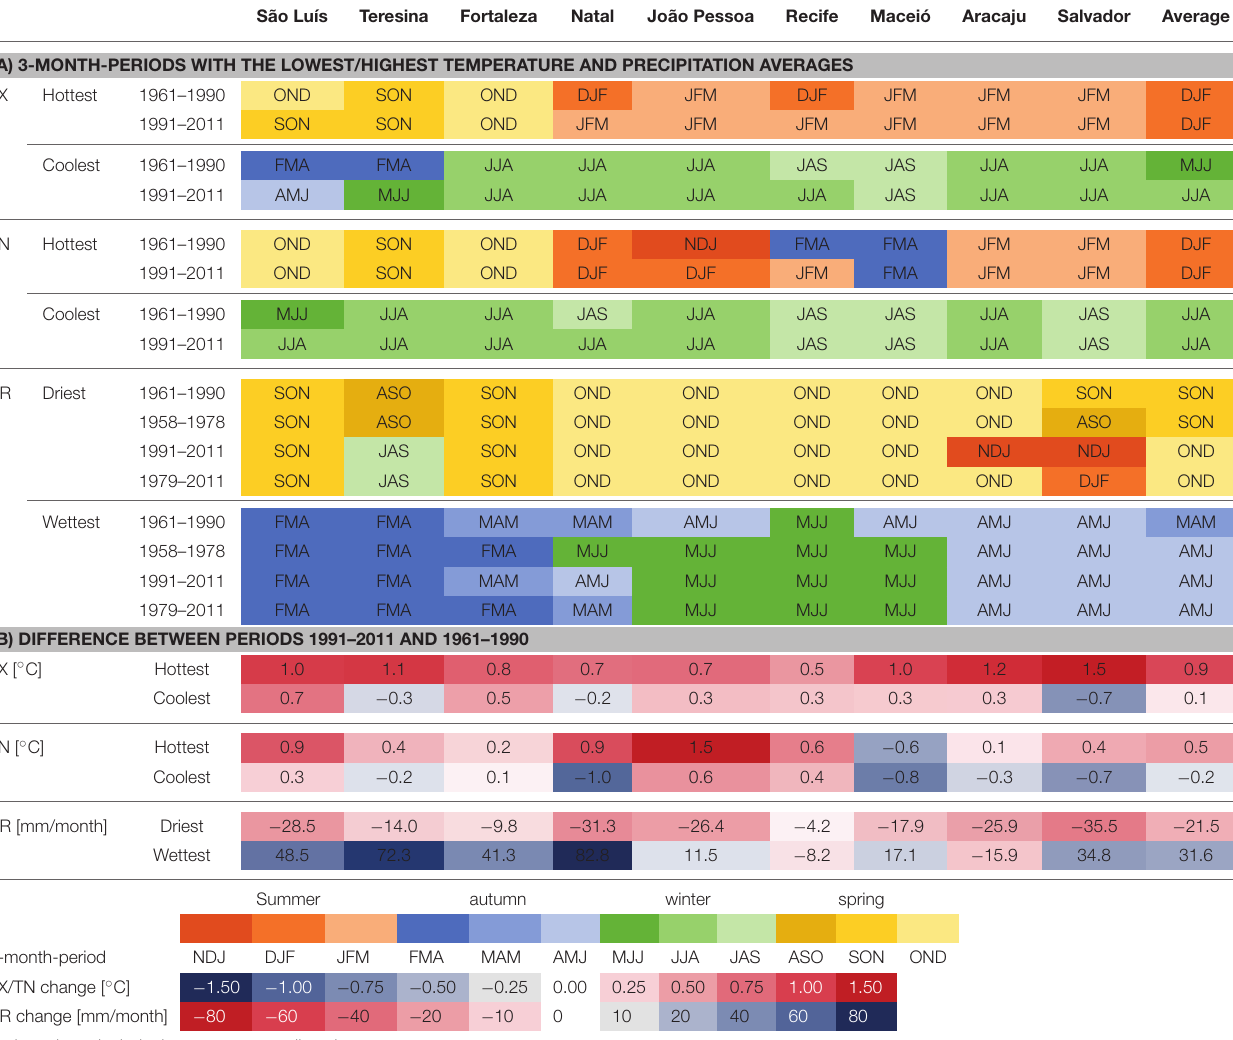
TABLE 4 | (A) Comparison of the timing of the 3 months with the lowest/highest temperature (TX, maximum temperature; TN, minimum temperature) and precipitation (RR) average within the analysis periods 1961–1990 and 1991–2011; for precipitation the results are also compared to those of the studies by Rao and Hada (1990) for 1958–1978 and by Rao et al. (2016) for 1979–2011; (B) Changes in the average values in period 1991–2011 as compared to 1961–1990 for the respective 3-month periods with the lowest and highest